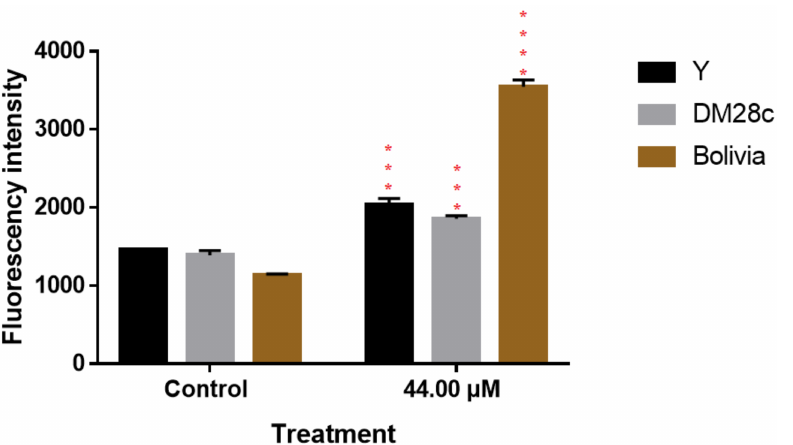
Figure 7. ROS production by Trypanosoma cruzi 24 h after being exposed to DETC nanoparticles. The parasites were exposed to a concentration of 44.0 µ M of NPD for 24 h. Results are presented as mean ± standard deviation of the percentage of parasitic inhibition in a triplicate system and for the statistical analysis of the ANOVA test, together with Tukey’s post hoc test ( p < 0.001 (***); p < 0.0001 (****). In order to verify differences, the profile of each strain was compared against the